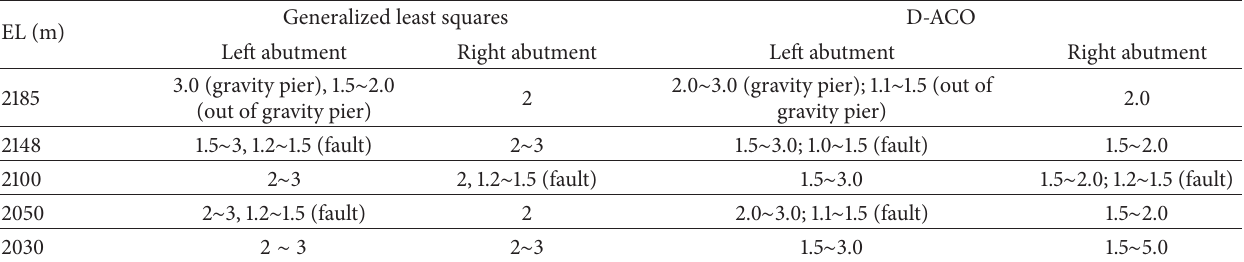
Table 7: Point safety factor of